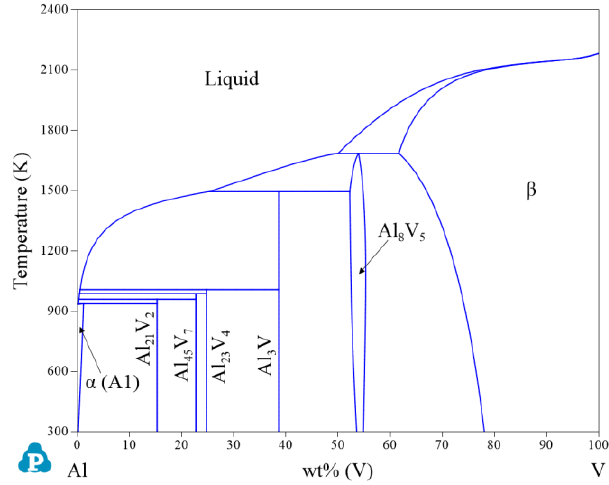
Figure 5. Calculated Al-V phase diagram using the thermodynamic parameters obtained by Gong et al. [32].